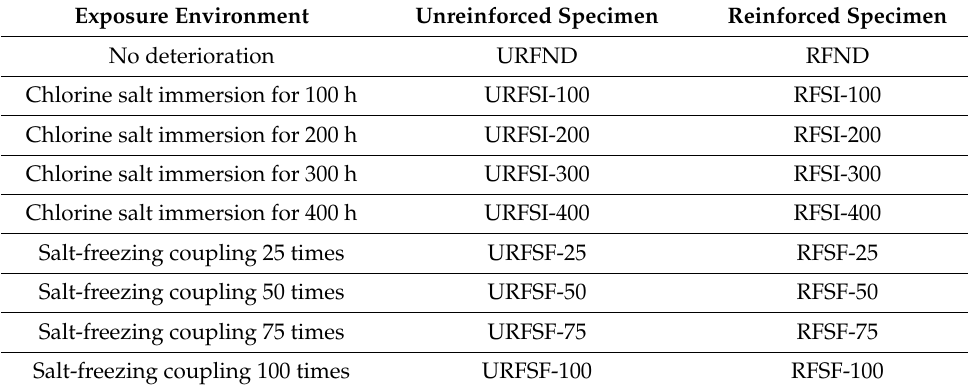
Table 4. Number of concrete specimens.